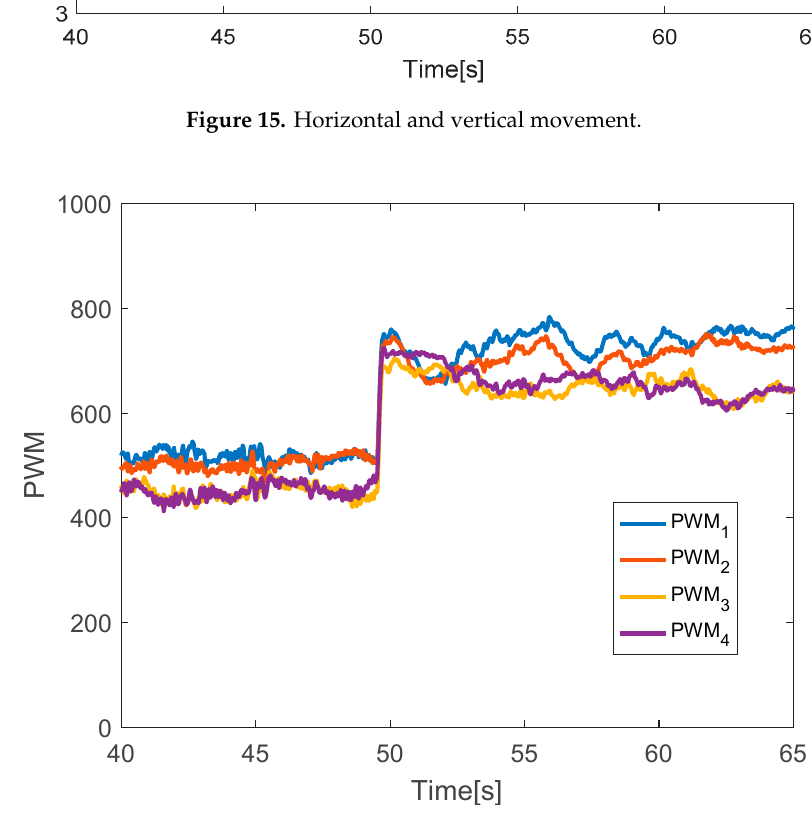
Figure 16. PWM inputs. Figure 16. PWM